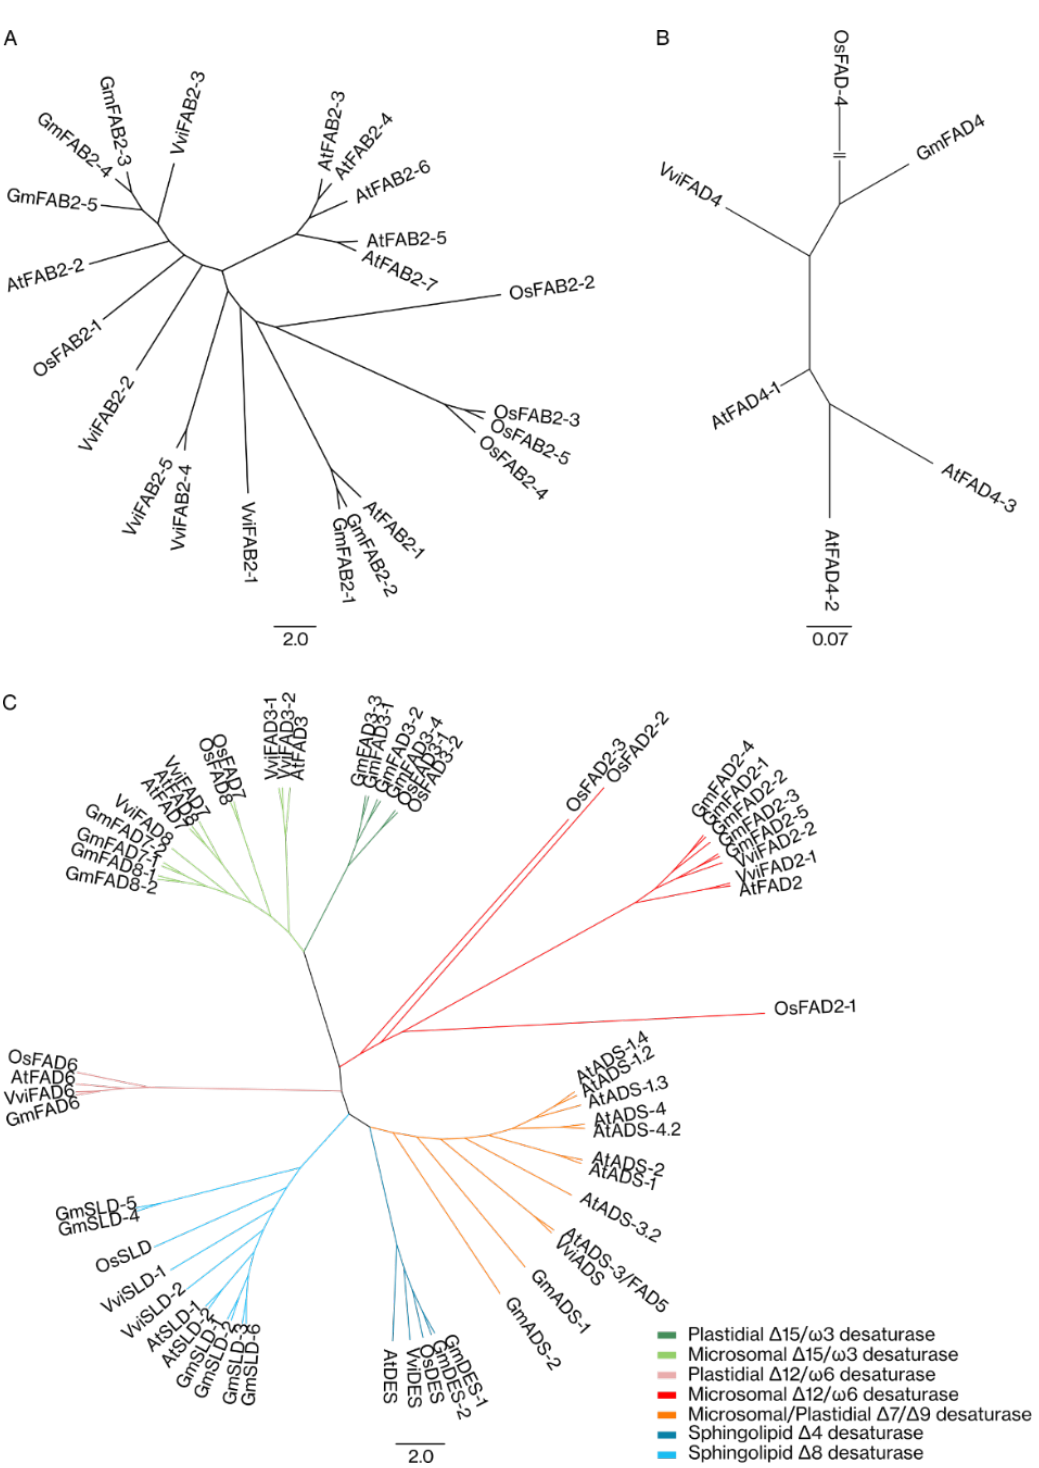
Figure 2. Maximum likelihood phylogenetic tree of the Vitis vinifera , Arabidopsis thaliana , Glycine max , and Oryza sativa FA desaturases superfamily. ( A ) Phylogenetic tree of the SAD proteins ( B ) Phylogenetic tree of the Δ3 desaturase proteins; ( C ) Phylogenetic tree of the Δ9 desaturase, Δ12/ω6 desaturase, Δ15/ω3 desaturase, sphingolipids Δ4 and the sphingolipid Δ8 desaturase. In ( B ), the root was truncated with a double dash totalling 0.49 changes per branch length. Scale bar represents the number of estimated changes per branch length.